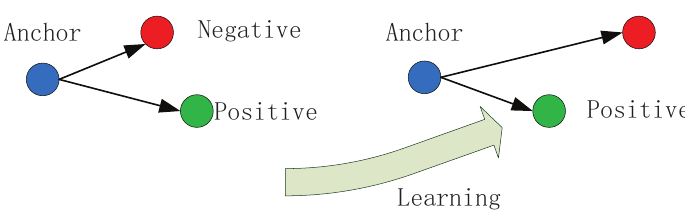
Figure 5. Schematic diagram of triplet-loss